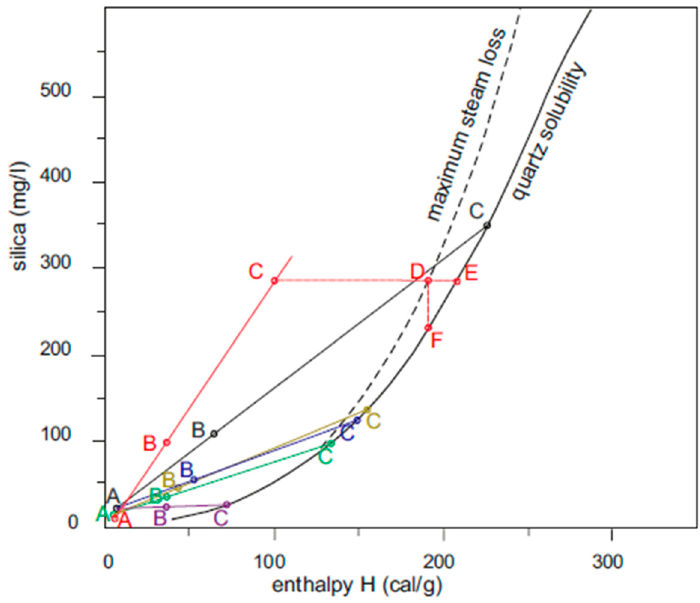
Figure 8. Diagram of dissolved silica (SiO 2 ) versus enthalpy (H) in mixed thermal and cold waters (based on [3]); points and lines: red—GT-1, black—C-1, blue—KT-1, purple—ST-1, green—LZT-1, yellow—L-2; A—concentration of silica in ordinary waters (black—for waters from Jelenia Góra-Cieplice area, green—for L ą dek-Zdrój waters, red—for Duszniki-Zdrój waters); B—concentrations of silica in thermal waters; C—concentrations of silica in primary deep waters except for GT-1, indicated by point F; D—enthalpy at steam loss temperature; E—silica concentration at the assumed steam separation temperature.